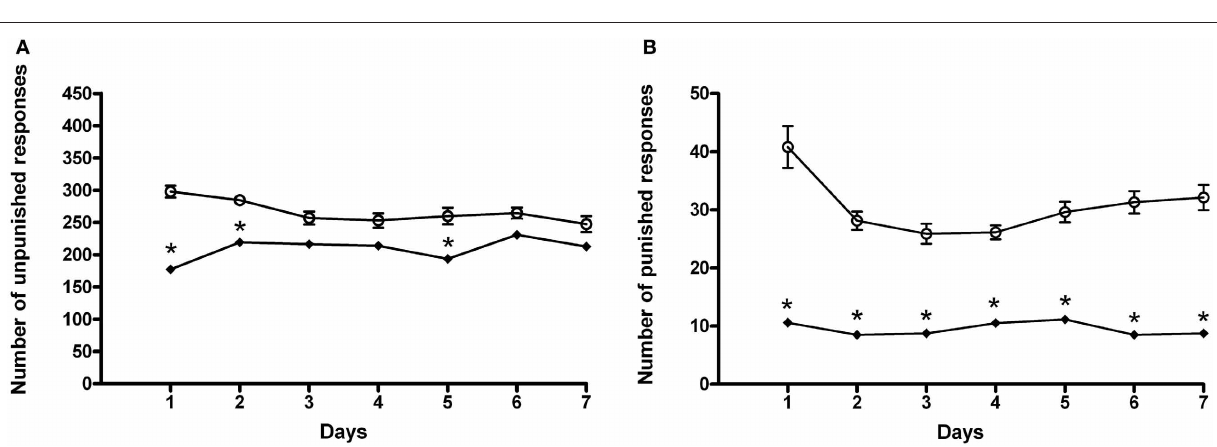
Frontiers in Behavioral